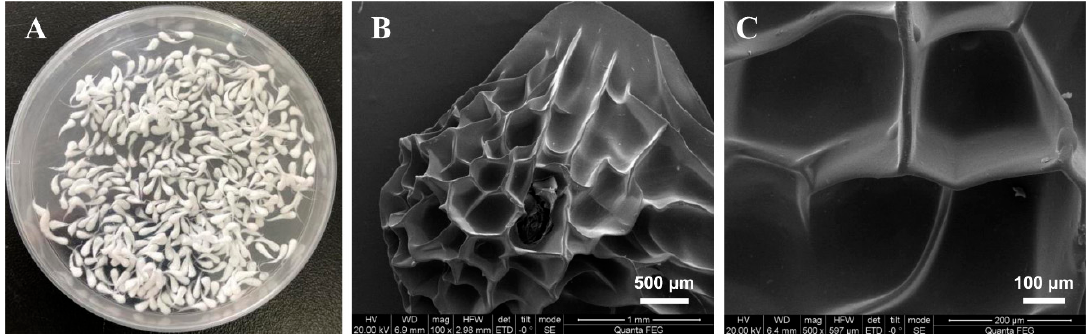
Figure 3. ( A ) Digital photograph of Alg–PAM; ( B ) Scanning electron microscope (SEM) Image of Alg–PAM; and ( C ) partial enlargement of ( B ).